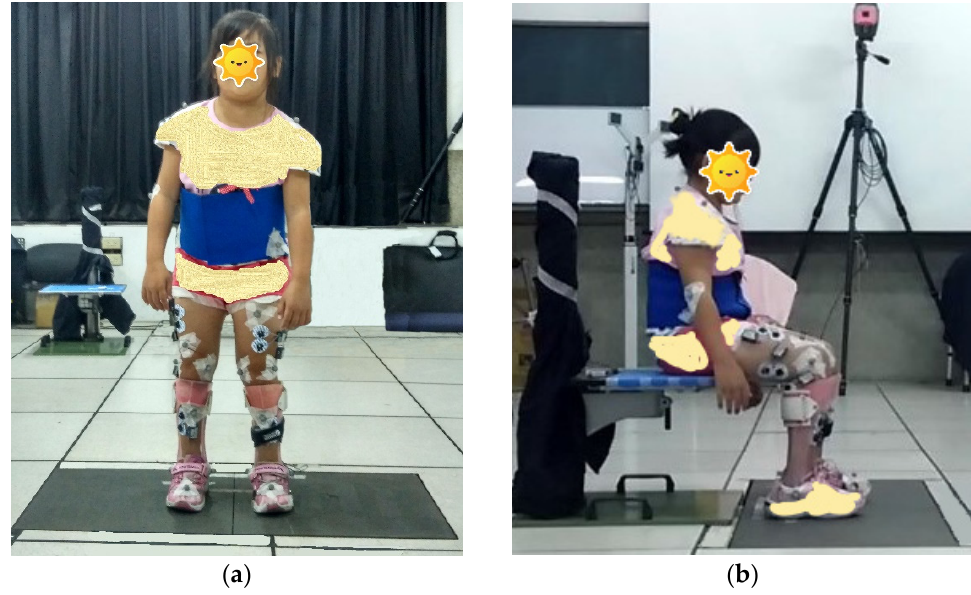
Figure 1. Postural tasks in the study: ( a ) static standing; ( b ) sit-to-stand .